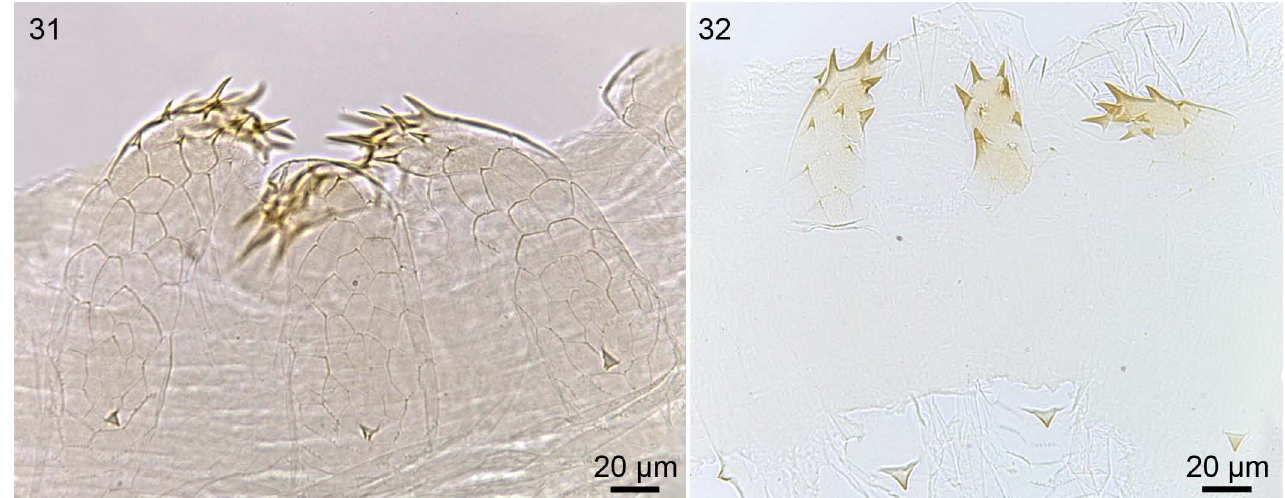
Figs 31–32. Enteric valves of Apicotermitinae: 31- Ruptitermes bandeirai ; 32- Tetimatermes oliveirae